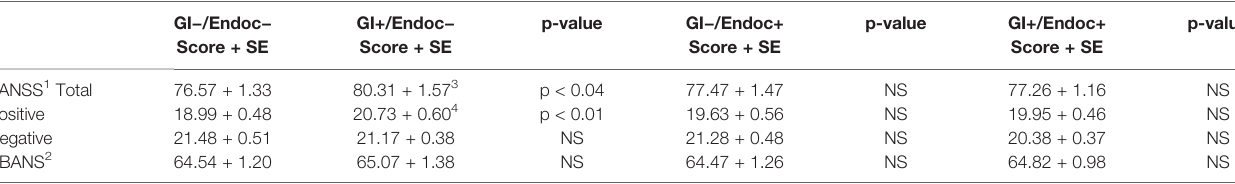
TABLE 5 | Cognitive and psychiatric symptom scores according to gut and endocrine